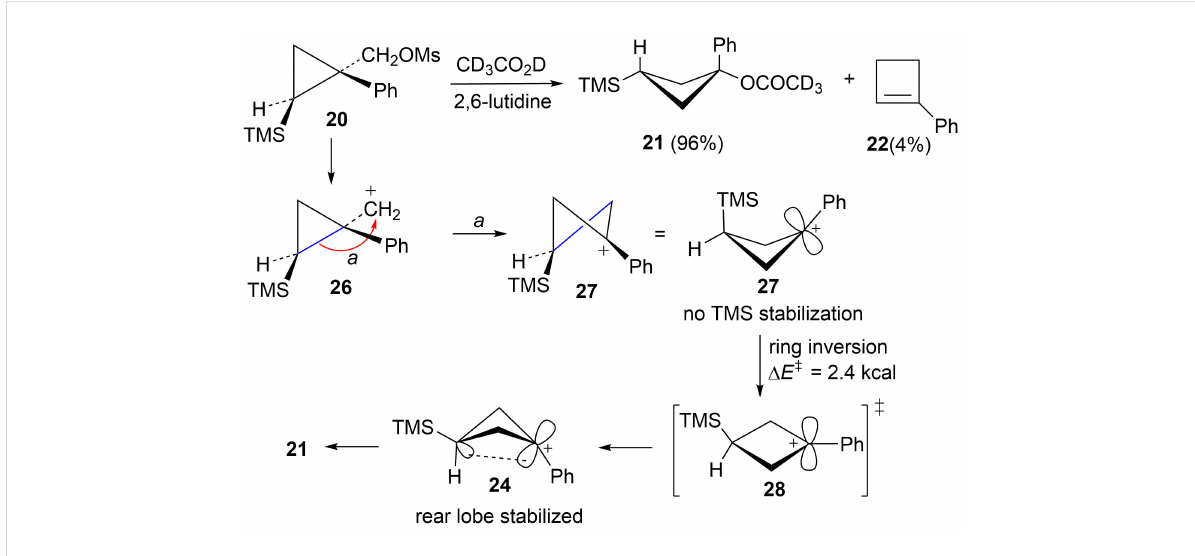
Scheme 6: Reaction of mesylate 20 in CD 3 CO 2 D.